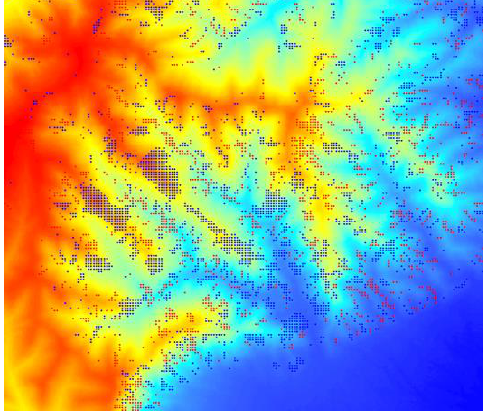
Figure 4. The checking points with residuals larger than 10 meter distribution in 5-meter grid DSM automatically generated with Forward-Backward stereo views images 4.